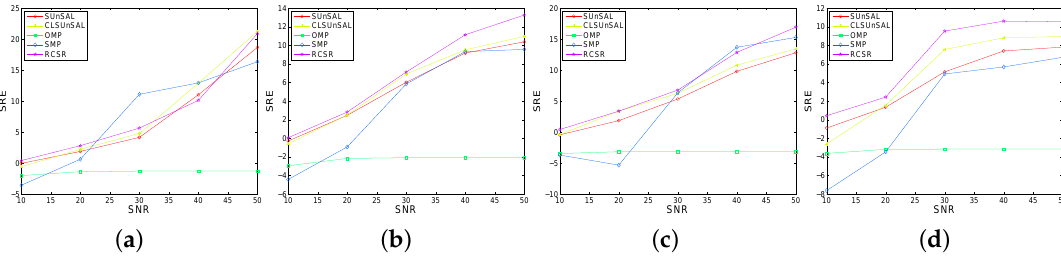
Figure 7. Performance of SRE as a function of SNR under correlated noise when the number of endmembers is 4 with the ( a ) LMM; ( b ) FM; ( c ) GBM and ( d )